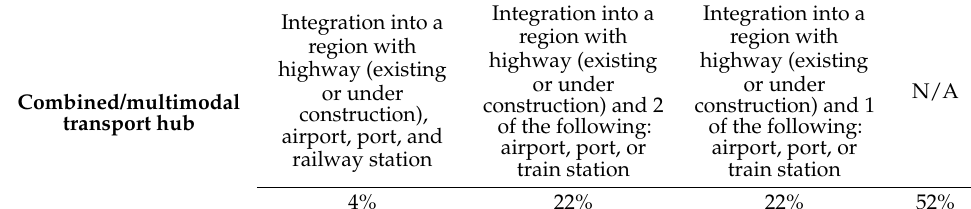
Table 5. Land-use commitment (%) of 27 organized receptors. <70% of total land 70–75% of total land >75% of total land Industrial 50% 36% 14% <10% of total land 10–20% of total land >20% of total land Open space (green) 32% 50% 18% <10% of total land 10–20% of total land >20% of total land Roads and other common facilities 7% 71%